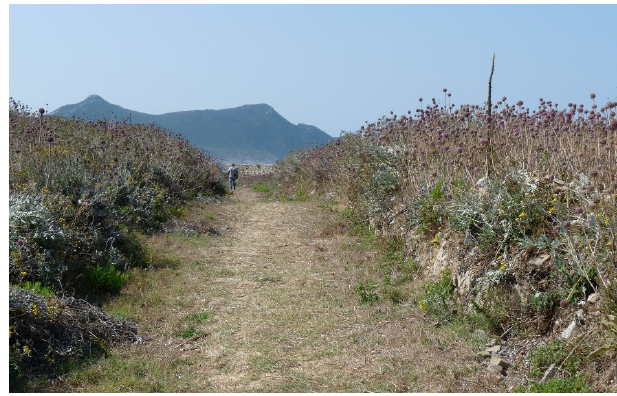
Figure 5. Allium commutatum Guss (TK076; Methoni Castle, Peloponnese) in its natural habitat.